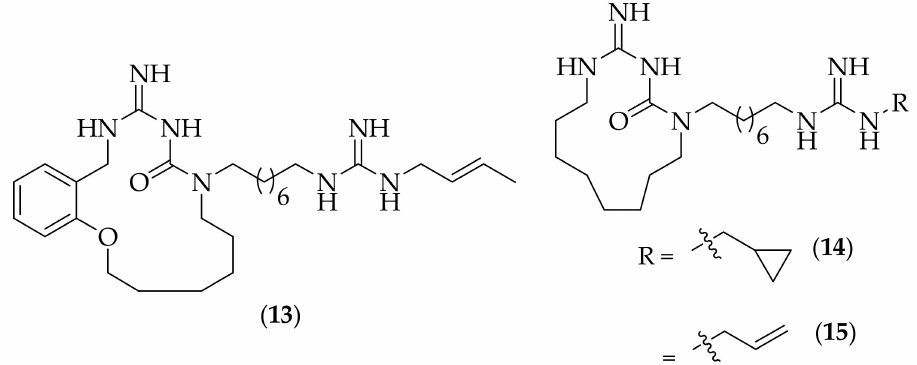
Figure 8. Cyclic guazatine-related analogs ( 13 ), ( 14 ), and ( 15